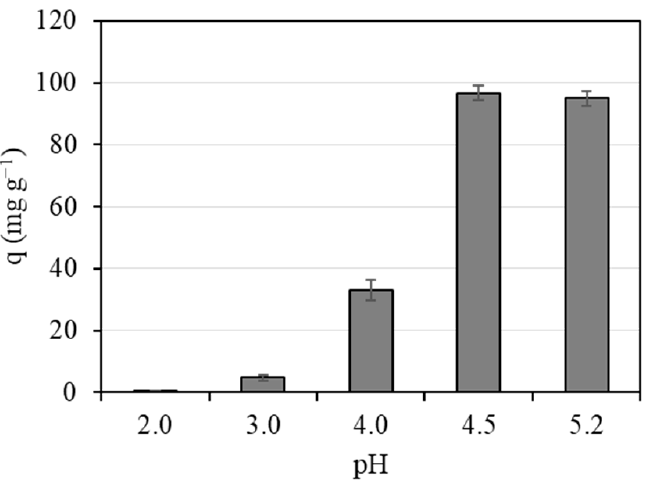
Figure 2. Effect of pH on adsorption capacity of Pb (II) by Spirulina ( C 0 = 5.63 mg L − 1 , S/L = 50 mg L − 1 ).